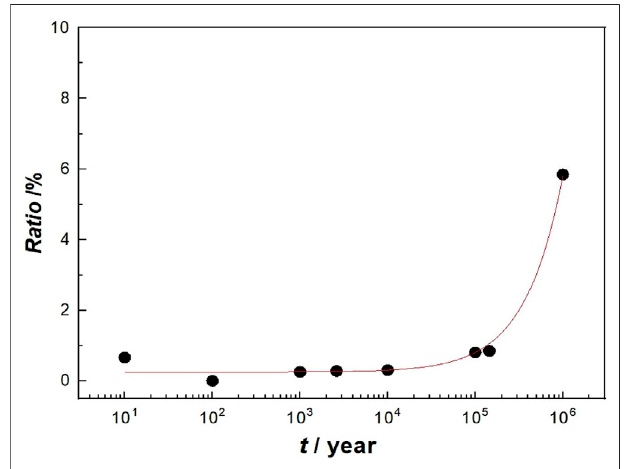
FIGURE 12 | Hydrogen permeation ef fi ciency of Q235 steel in highly compacted bentonite at different disposal time.